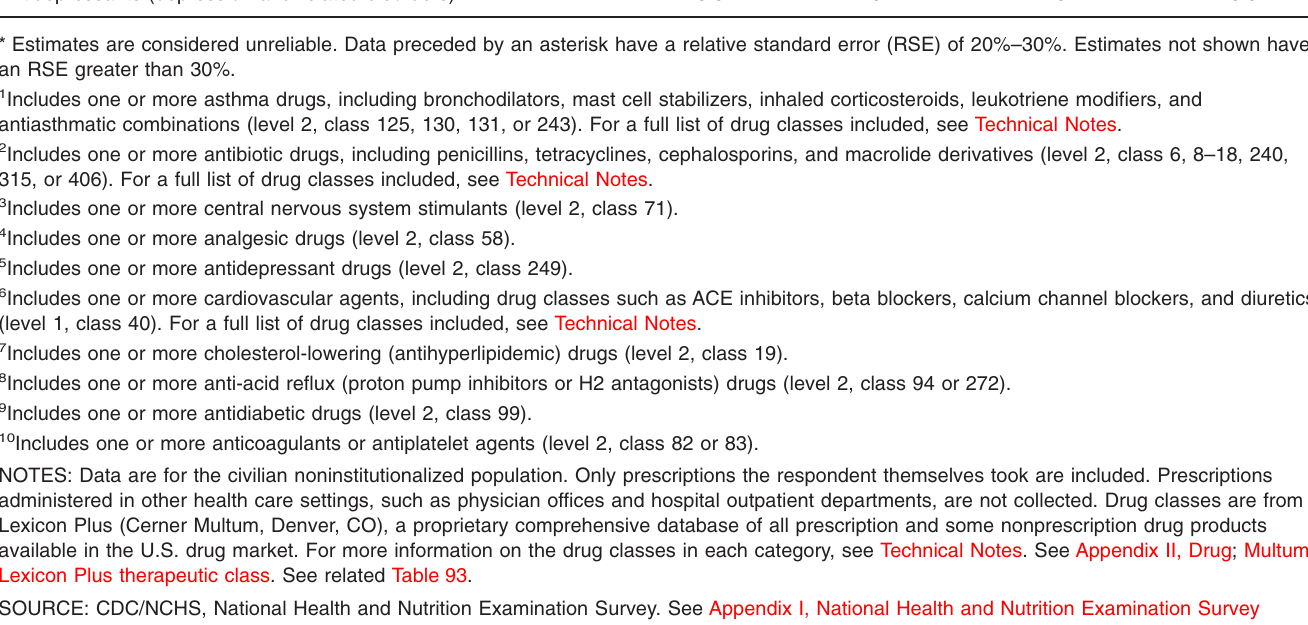
(common indications for